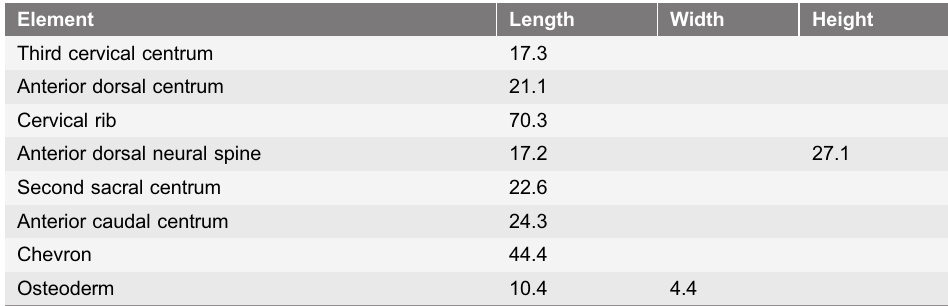
Table 1. Measurements of axial postcranial bones of Pseudochampsa ischigualastensis (PVSJ 567) in millimeters. Element Length Width Height Third cervical centrum 17.3 Anterior dorsal centrum 21.1 Cervical rib 70.3 Anterior dorsal neural spine 17.2 27.1 Second sacral centrum 22.6 Anterior caudal centrum 24.3